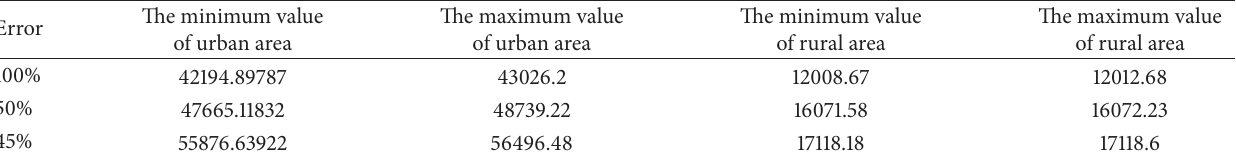
Table 5: The predicted consumer numbers of China local telephone under different control simulation errors.